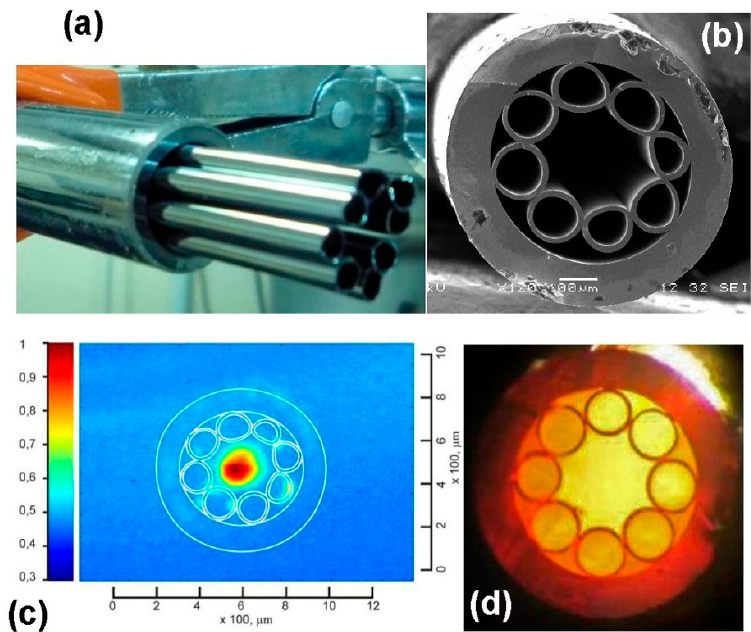
Figure 9. ( a ) The stacked perform of RF made of As 30 Se 50 Te 20 glass, the tube outer diameter—16 mm, the tube inner diameter—11 mm, the capillaries outer diameter—3 mm, the capillaries inner diameter—2.4 mm; ( b ) SEM image of the As 30 Se 50 Te 20 RF cleaved end face, the fiber diameter is 750 µ m; ( c ) the CO 2 -laser radiation intensity (in a.u.) distribution over the As 30 Se 50 Te 20 RF cross section. White lines show the cross section of the RF; and, ( d ) optical microscope image of the As 2 S 3 RF cleaved end face, the fiber diameter is 820 μ m.